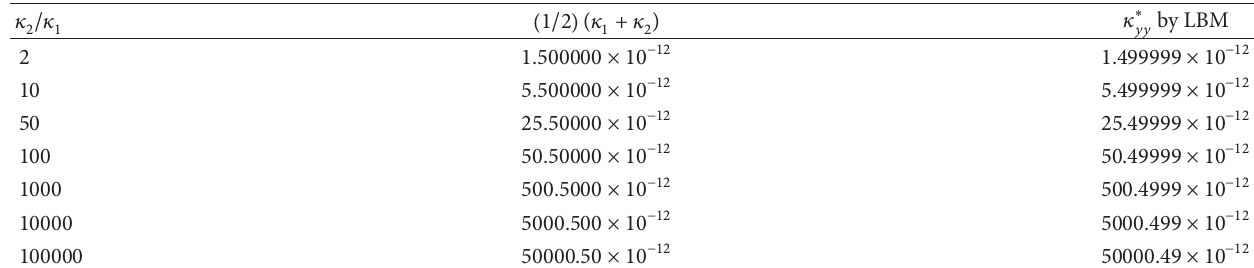
Figure 3: Distributions of 𝑝 , 𝑢 , and V , ] eff = 0 m 2 s −1 , Table 2: Verification of computed 𝜅 ∗ 𝑦𝑦 , 𝜅 1 = 10 −12 m 2 and ] eff = 0 m 2 s −1 .